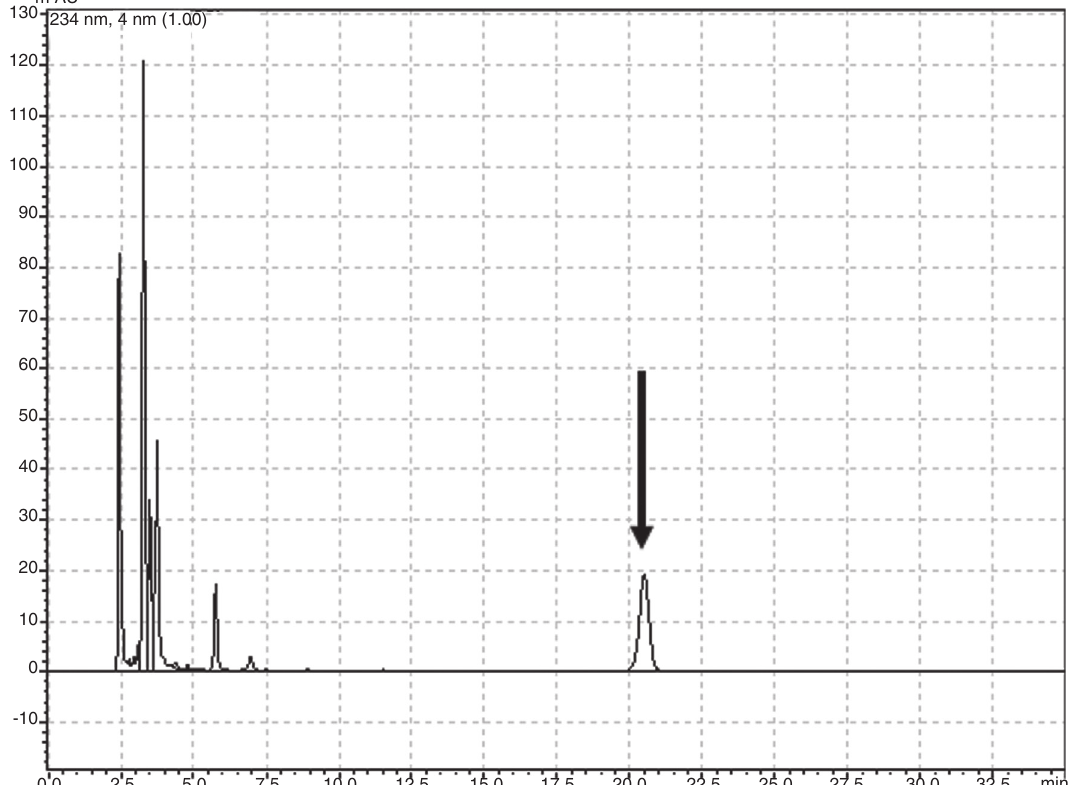
Figure 2 Elution of creatinine from the same control subject’s urine shown in Figure 1. HPLC analysis was the same as in Figure 1 but this chromatograph is from the spectrophotometer positioned after the fluorescence detector. The chromatograph shows the absorbance of the eluent at 234 nm with the creatinine indicated by the arrow eluting at 20.4 min.